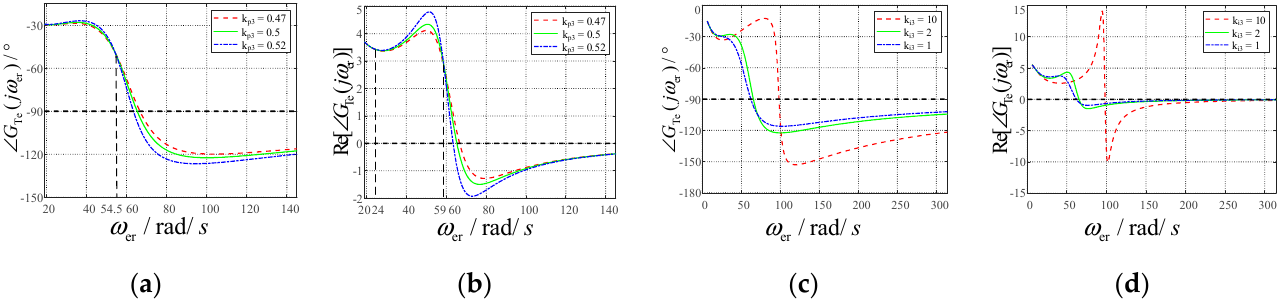
Figure 8. Frequency response of the gain of ∆ T e under different control parameters of RSC current control loop: ( a ) phase vary with ω er under k p3 ; ( b ) real part vary with ω er under k p3 ; ( c ) phase vary with ω er under k i3 ; ( d ) real part vary with ω er under k i3 .